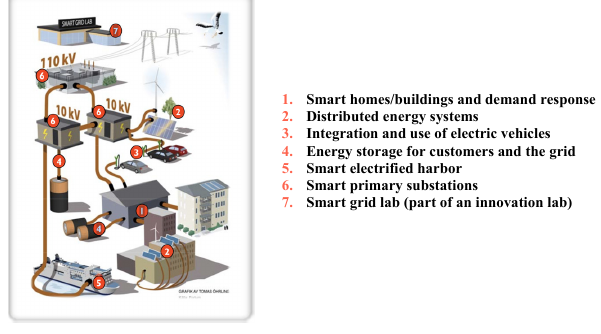
Figure 4. A large-scale smart grid in SRS.